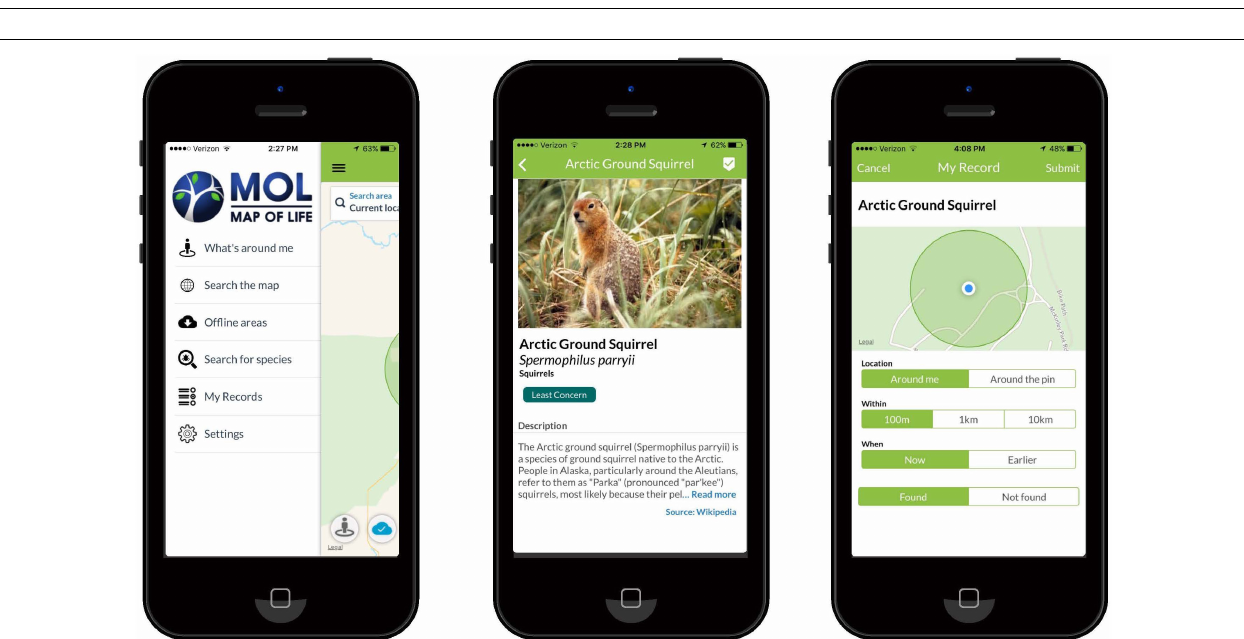
FIGURE 6 | Map of life mobile application: home page, species information page, and record observation page.